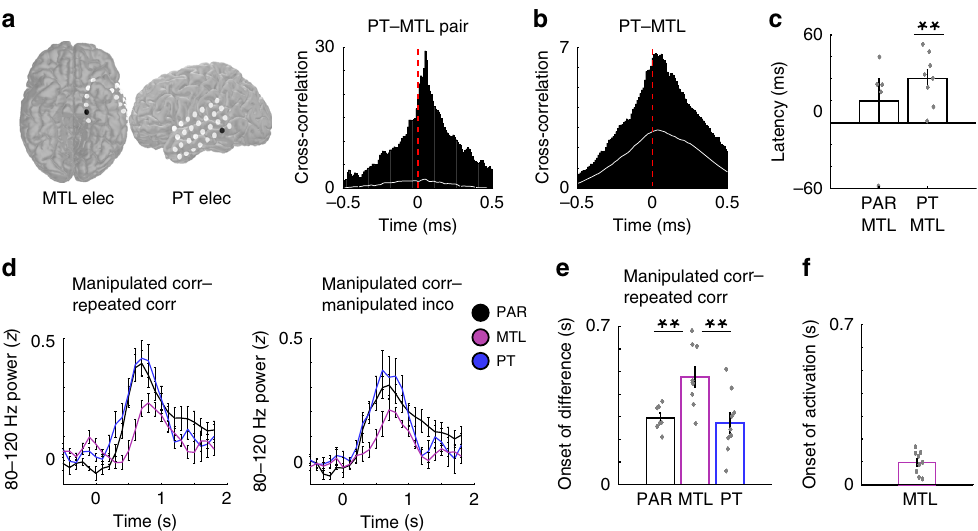
Fig. 5 Differences in 80 – 120 Hz power between present and remembered visual experience emerge in visual association cortex earlier than in the MTL. a Representative cross-correlation of 80 – 120 Hz power between a PT and MTL electrode in an example participant. The chance cross-correlation for this electrode pair is indicated by the white line. b Average cross-correlation of 80 – 120 Hz power between the PT and MTL electrodes across participants. The chance cross-correlation for the average across all electrode pairs is indicated by the white line. c Average peak times (latency) of 80 – 120 Hz cross- correlograms for PT – MTL and PAR – MTL electrode pairs across participants. Average latency between PT and MTL electrodes across 8 participants was signi fi cantly greater than zero ( t (7) = 4.78, p = 0.002, two-tailed paired t test). d Average time series of differences between the manipulated and repeated correct conditions (left) and manipulated correct and incorrect conditions (right) across 9 PT, 7 PAR, and 9 MTL participants (200 ms sliding windows, 50% overlap; image appears at t = 0). e Average estimated onset of differences in 80 – 120 Hz power between manipulated correct and repeated conditions in 9 PT, 7 PAR, and 9 MTL participants (left). The differences in 80 – 120 Hz power between manipulated correct and repeated conditions arose signi fi cantly earlier in PT and PAR compared to MTL (PT vs MTL, t (16) = − 3.21, p = 0.005; PAR vs MTL, t (14) = − 3.32, p = 0.005). Asterisks (**) indicate signi fi cance at p < 0.01; two-sided unpaired t test. f Average estimated onset of 80 – 120 Hz MTL power (activation) across 9 participants. All error bars indicate standard error of